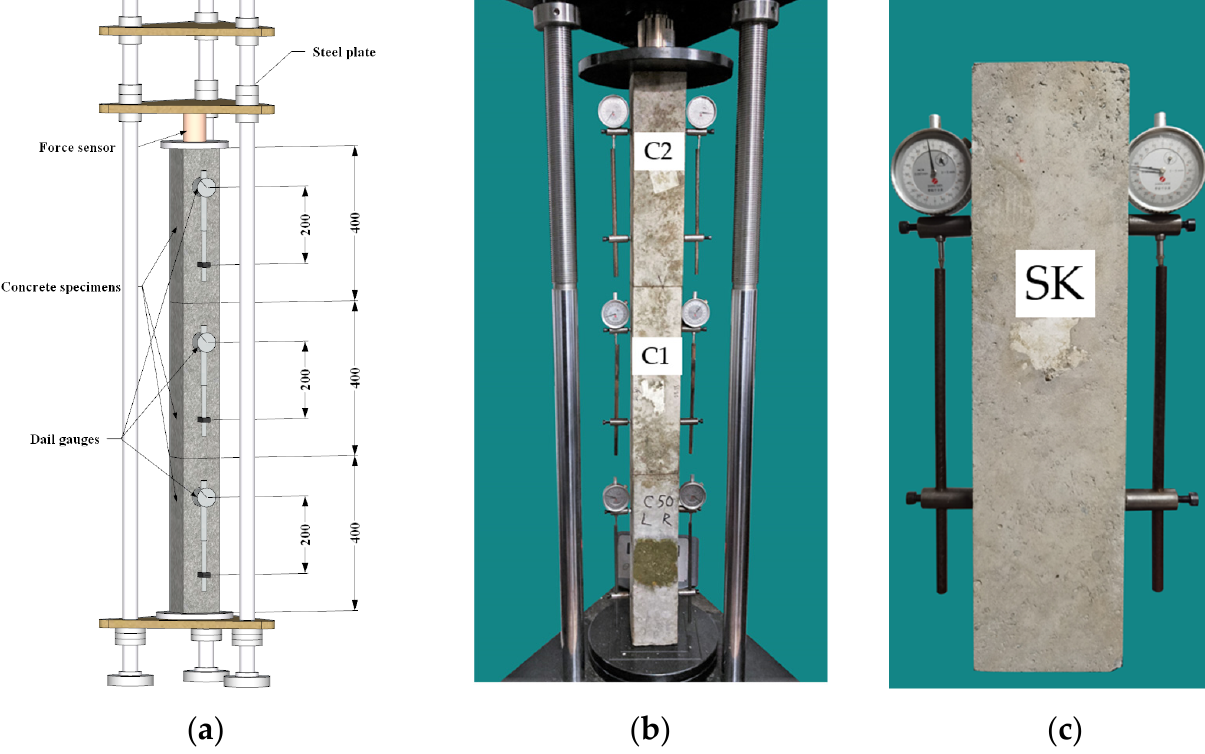
Figure 9. The creep and shrinkage experiments on the concrete specimens: ( a ) a schematic of the creep loading test, ( b ) the creep loading test and ( c ) the shrinkage test. (C1 and C2 are standard creep tests specimens, SK is shrinkage test specimen.)